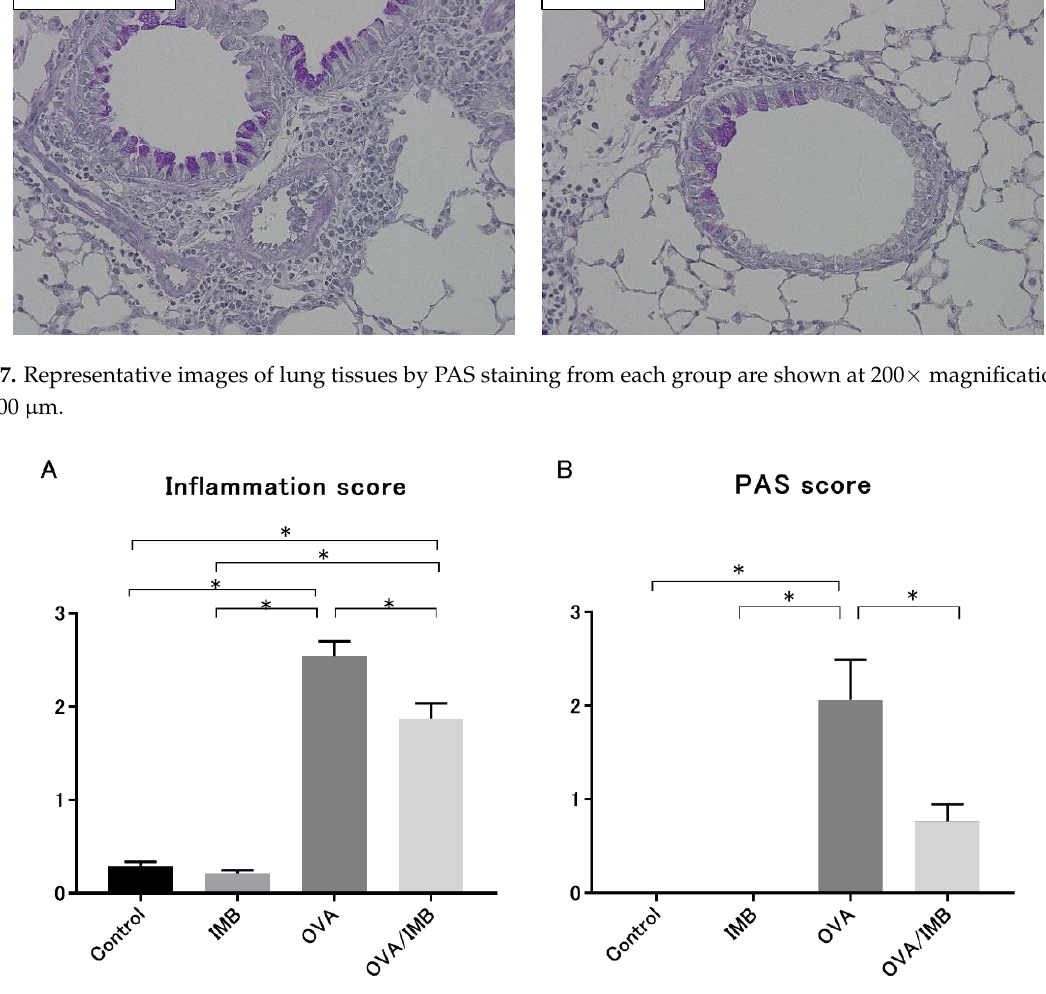
Figure 8. Histological examination of lung tissues. Lung inflammation was evaluated by HE staining, and hyperplasia of goblet cells was assessed by PAS staining. The semi-quantitative scores of inflammatory infiltration and goblet cell hyper- plasia were significantly lower in the OVA/IMB group than in the OVA group ( A , B ). Values represent the mean ± standard error of the mean. * p < 0.05.